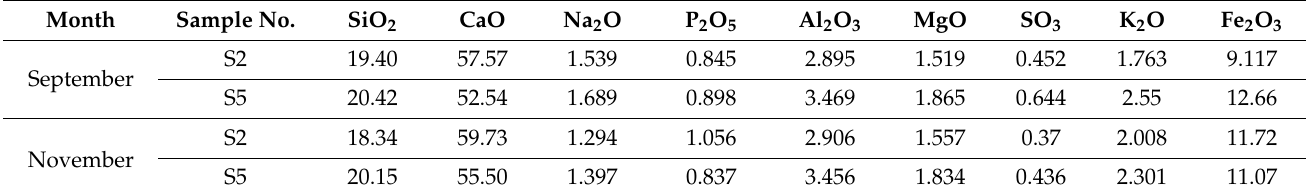
Table 10. Seasonal variations of elemental composition for samples No. S2 and S5. Month Sample